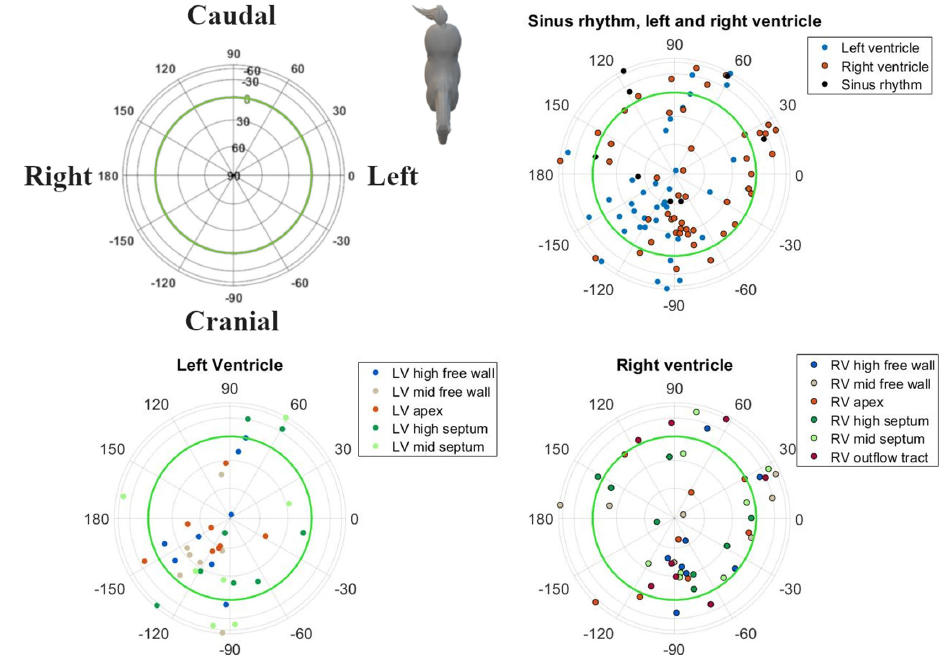
Figure 3. Spatial directions of the initial electrical axis (IEA) of the QRS complex for individual spatial directions of induced VPDs, visualized using a Lambert azimuthal equal-area plot. The spatial direction of the IEA was calculated during the first 40 ms of the QRS complex. Dots inside the green circle represent a dorsal IEA, while outside dots represent a ventral IEA. Left is 0°, caudal is 90° azimuth and dorsal is 90° elevation.